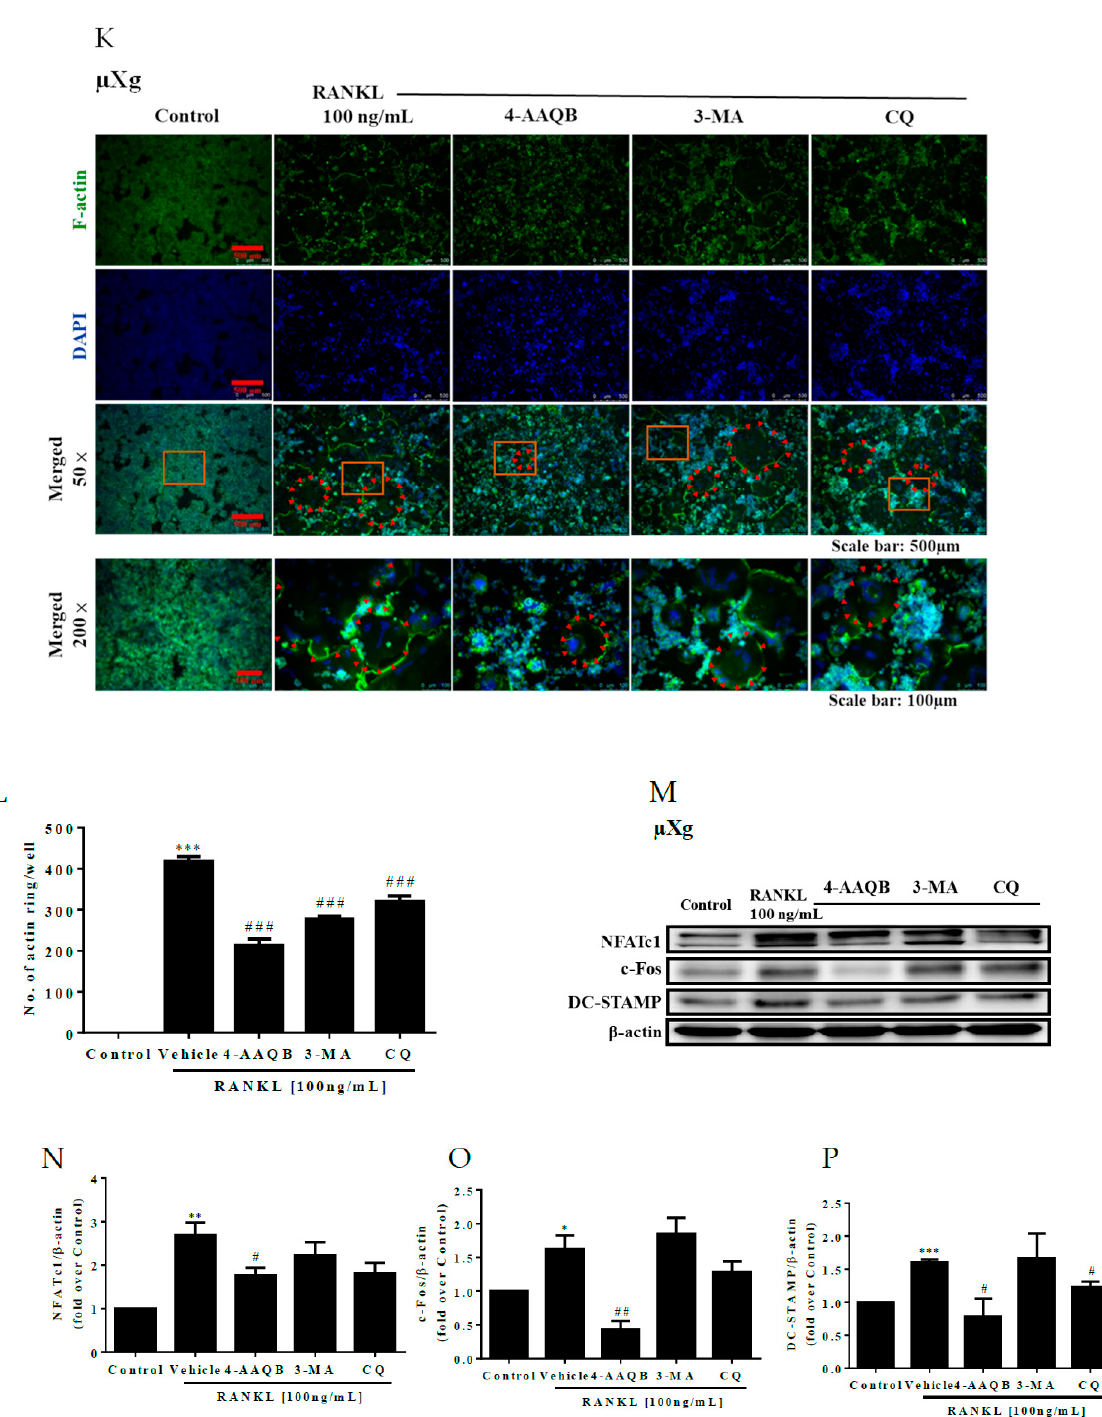
Figure 6. Autophagy inhibitor attenuation of osteoclast formation after μ Xg stimulation. Autophagy proteins were assayed by western blotting ( A ) . The quantitative results of LC3B-II/LC3B-I ( B ), p62 ( C ), Atg 7 ( D ), and Atg 5 ( E ) represent the mean ± SEM ( n = 3). Cell viability was assayed by alamarBlue for 2 h after cell stimulation under μ Xg conditions for 24 h; stimulation by 3-MA ( F ) or CQ ( G ) continued for 72 h. The quantitative results represent the mean ± SEM (n = 3). TRAP staining was performed after cell stimulation under μ Xg ( H ) conditions for 24 h. and the cells treated with 4-AAQB (10 μ M), 3-MA (1 mM), or CQ (10 μ M) combined with RANKL for 72 h. The quantitative results of the number of TRAP (+) osteoclasts/well ( I ) and area of TRAP (+) osteoclasts (%) ( J ) represent the mean ± SEM ( n = 6). Fluorescent staining was performed after stimulation under μ Xg ( K ) conditions for 24 h, and the cells treated with 4-AAQB, 3-MA, or CQ combined with RANKL for